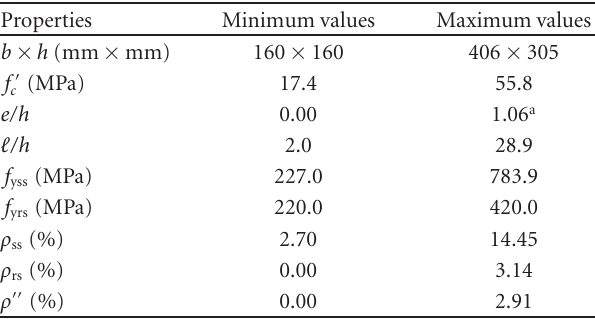
Table 2: Summary of geometric and material properties of com- posite column specimens a